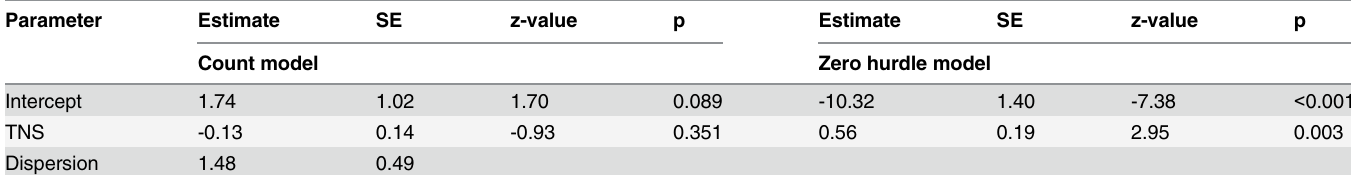
Table 2. Parameter estimates of the hurdle model for Aceria tosichella lineage MT-1 relating the observed abundance (truncated negative binomial distribution with log link) and prevalence (binomial distribution with logit link) to thermal niche suitability